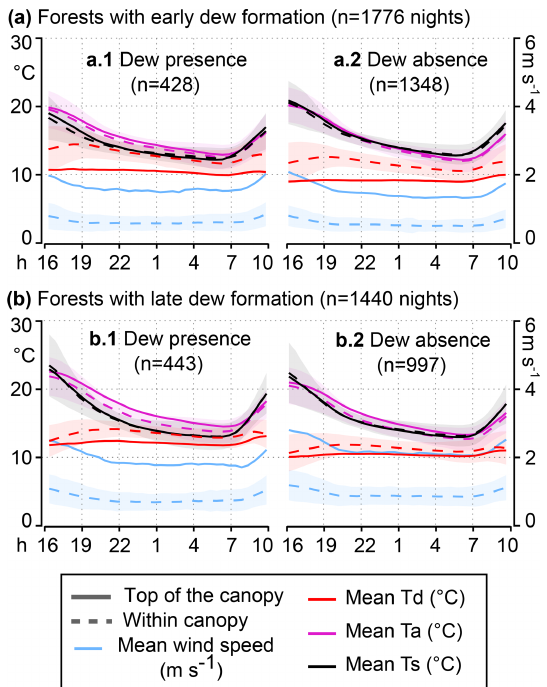
Figure 10. Nocturnal cycles for two populations of forests with the mean value of meteorological parameters calculated on a stack of n nights ( n indicated in parenthesis). The solid lines represent the top of the canopy, and the dashed lines represent within canopy. The shaded areas indicate ± 1 standard deviation of the mean, shown within the canopy only (for visualization purposes). (a.1) and (b.1) are based on nights with dew formation, and (a.2) and (b.2) are based on nights without dew